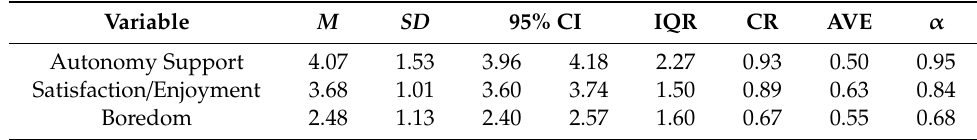
Table 3. Scale of reliability and composite validity.